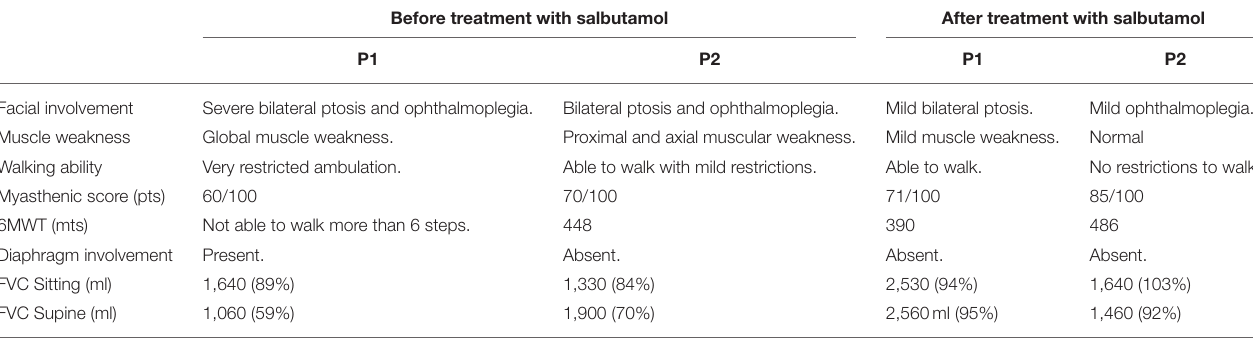
TABLE 1 | Response to treatment, adding oral β 2 adrenergic agonists (salbutamol). Before treatment with